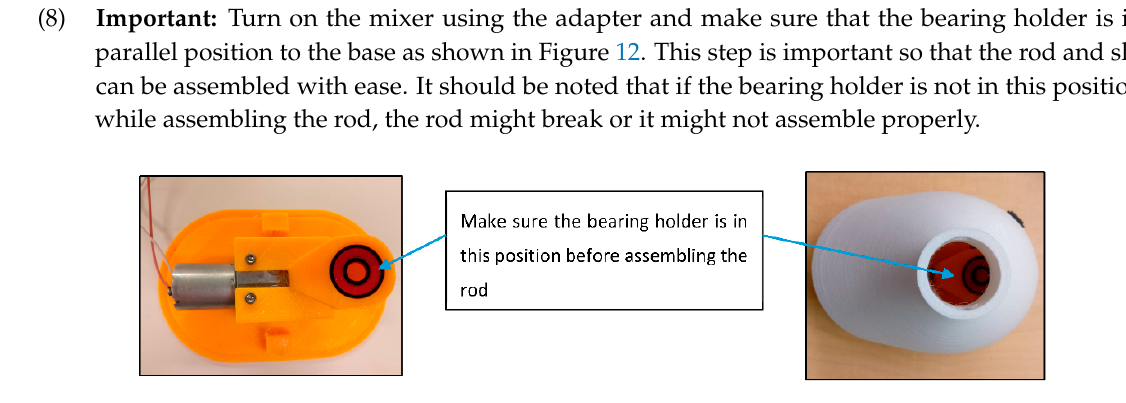
Figure 12. Bearing holder position should be parallel to the base and the motor.